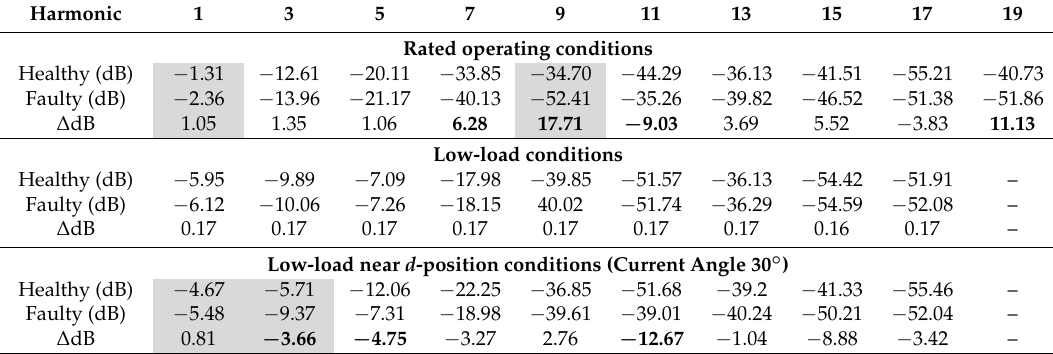
Table 3. Spectral content of the ZSVC of the analyzed fPMa-SynRM under healthy and 40% static eccentricity